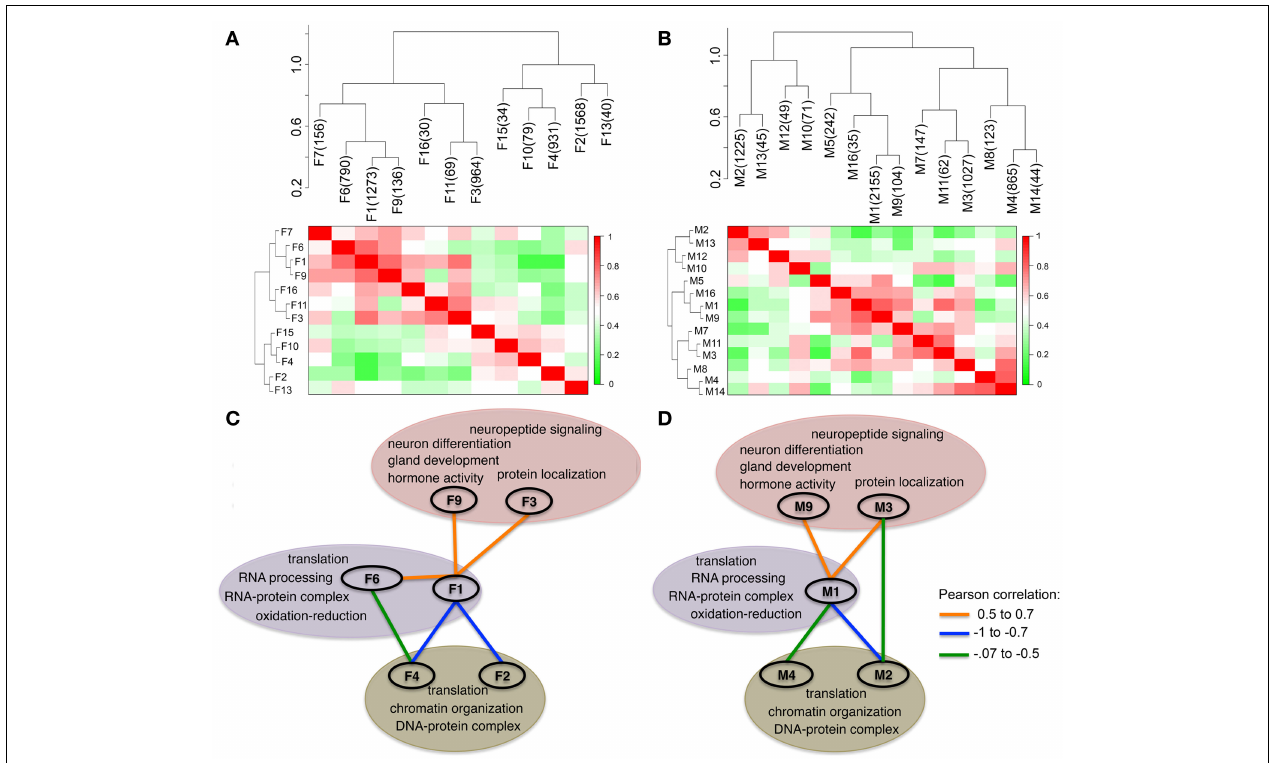
functions that characterize the modules are highlighted.There is inverse association between networks enriched for transcription, translation, and energy metabolism (F1/M1 and F6 in purple bubble) and networks enriched for DNA packaging (F2/M2 and F4/M4 green bubble). In both males and females, modules enriched in hypothalamus related functions (F3/M3, F9/M9 in pink bubble) are positively correlated with M1 and F1.The colored lines connecting the modules show the Pearson product correlations between the